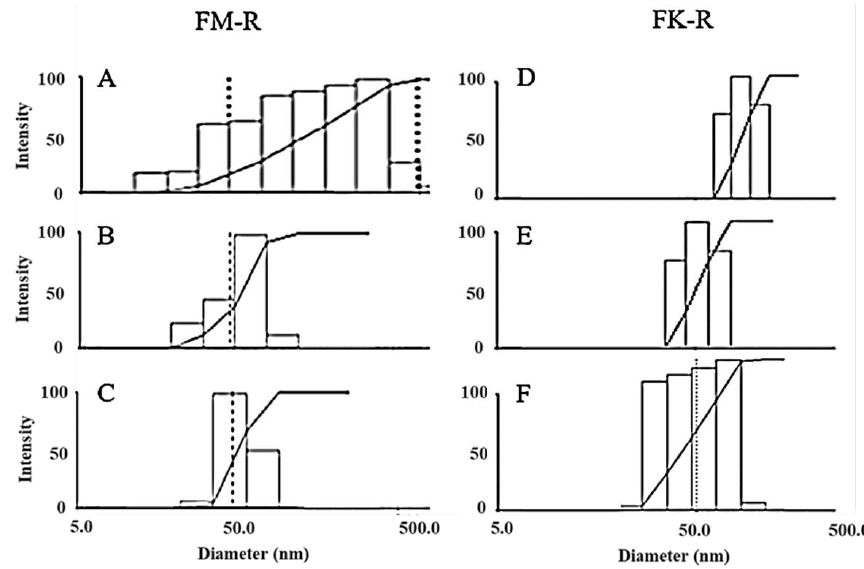
Figure 3. The molecular size distribution of flaxseed mucilage RG-I (FM-R) in 0.1 M NaCl ( A ), in 0.1 M NaOH ( B ), and in 0.5 M NaOH ( C ), and flaxseed kernel RG-I (FK-R) in 0.1 M NaNO 3 ( D ), in 6 M NH 4 OH ( E ), and in 0.5 M NaOH ( F ) determined by dynamic light scattering (at 0.1 mg/mL solution concentrations, 23 °C).